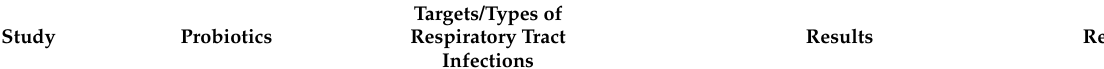
Table 4. Probiotics and respiratory tract